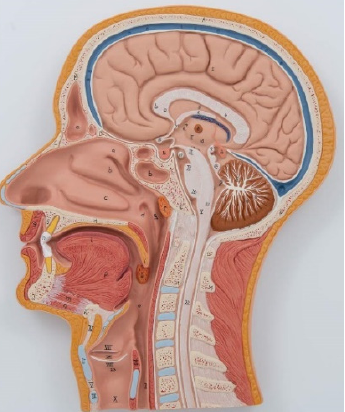
Figure 3. Example of human UA medical school teaching model used by Ted B. Martonen. Adapted with permission from Ref. [23] . 2002, Ted B. Martonen.